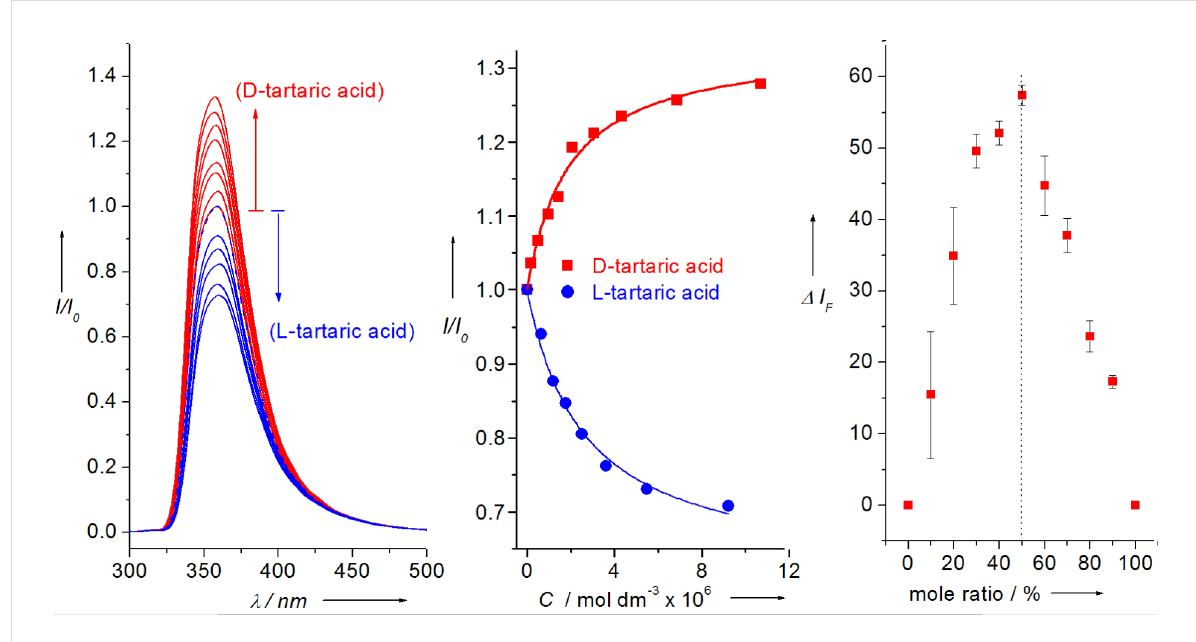
Figure 9: Chiral discrimination of D- and L-tartaric acid by ( R )- 8 at pH 5.6. [( R )- 8 ] = 5.0 × 10 − 6 mol dm − 3 , at pH 5.6 in 0.05 mol dm − 3 NaCl (52.1% methanol in water), λ ex at 289 nm, 22 °C. The pH was kept at 5.6 with NaOH/HCl. (Left) Emission spectra. (Center) Normalized emission intensity) as a function of added tartaric acid concentration. Lines are fit to 1:1 binding isotherm (Right) Job plot of ( R )- 8 with D-tartaric acid at a constant total con- centration [D-tartaric acid] + [ R ] = 5.0 × 10 − 6 mol dm − 3 ; λ em at 358 nm. Reproduced with permission from [61]. Copyright 2004 John Wiley and Sons.